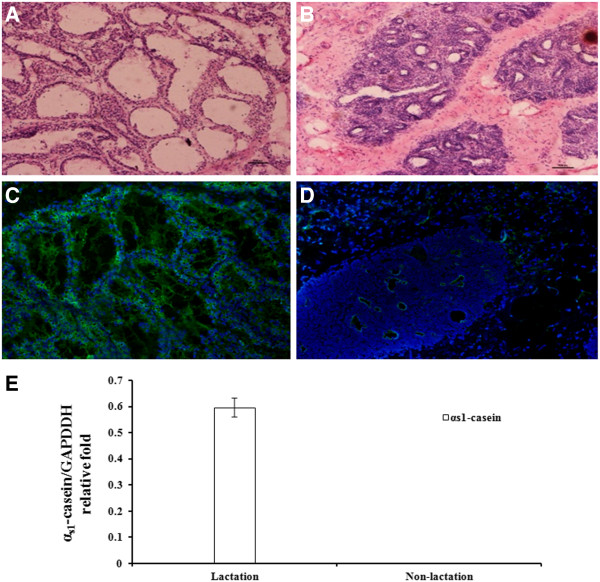
The microstructure and gene expression of lactating and non-lactating mammary gland tissue in the dairy cow. (A) Paraffin sections of bovine mammary gland in the lactation period (100×). (B) Paraffin sections of bovine mammary gland in the non-lactation period (100×). In (A) and (B), the MG sections were stained with hematoxylin-eosin using standard procedures. Nuclei are dyed blue by hematoxylin, and the cytoplasm is stained pink by eosin. Hematoxylin-eosin stained sections were analyzed using light microscopy. (C) Expression of α-casein in lactating bovine mammary glands (100×). (D) Expression of α-casein in non-lactating bovine mammary glands (100×). In (C) and (D), nuclei are in blue as marked by DAPI, and the α-casein signal is in green. Alpha-casein was detected using immunofluorescence using an anti-α-casein antibody followed by HRP-conjugated goat anti-rabbit IgG and analysis using fluorescence microscopy. (E) Expression of αs1-casein mRNA in lactating and non-lactating bovine mammary glands using real-time PCR.